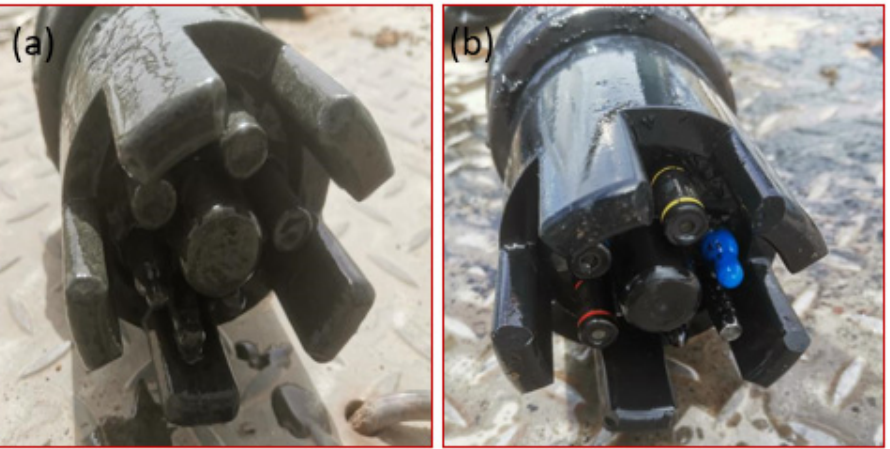
Figure 1. The integrated ammonium and nitrate sensors. ( a ) Being used for raw wastewater moni- toring in influent channels for 24 h without cleaning; ( b ) after